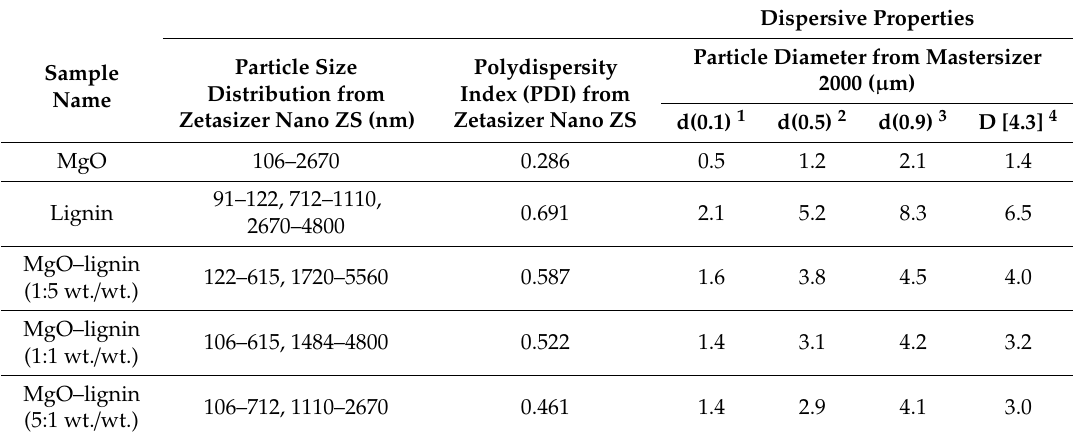
Table 1. Dispersive properties of MgO, lignin and inorganic-organic hybrid materials.